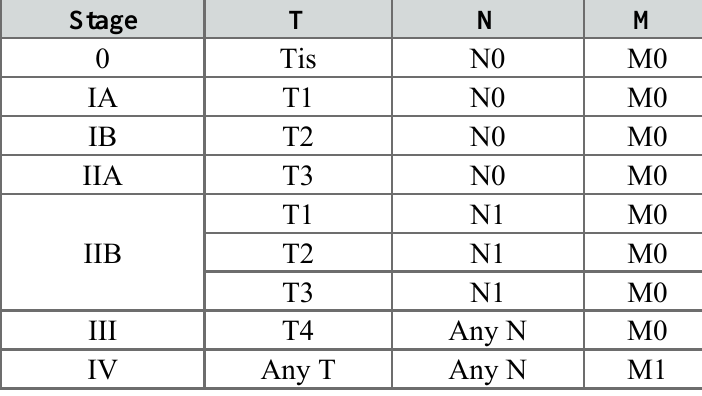
Table 2 . Pancreatic cancer staging groups (Adapted from